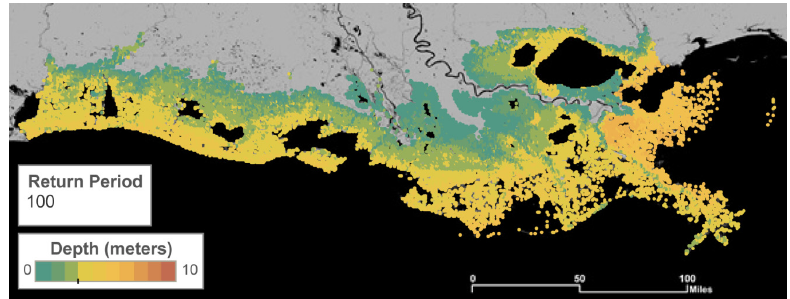
Figure 5. Maps of bias by grid point for detailed analysis sets D2, D3, and D11, 100 ‐ year flood depths.